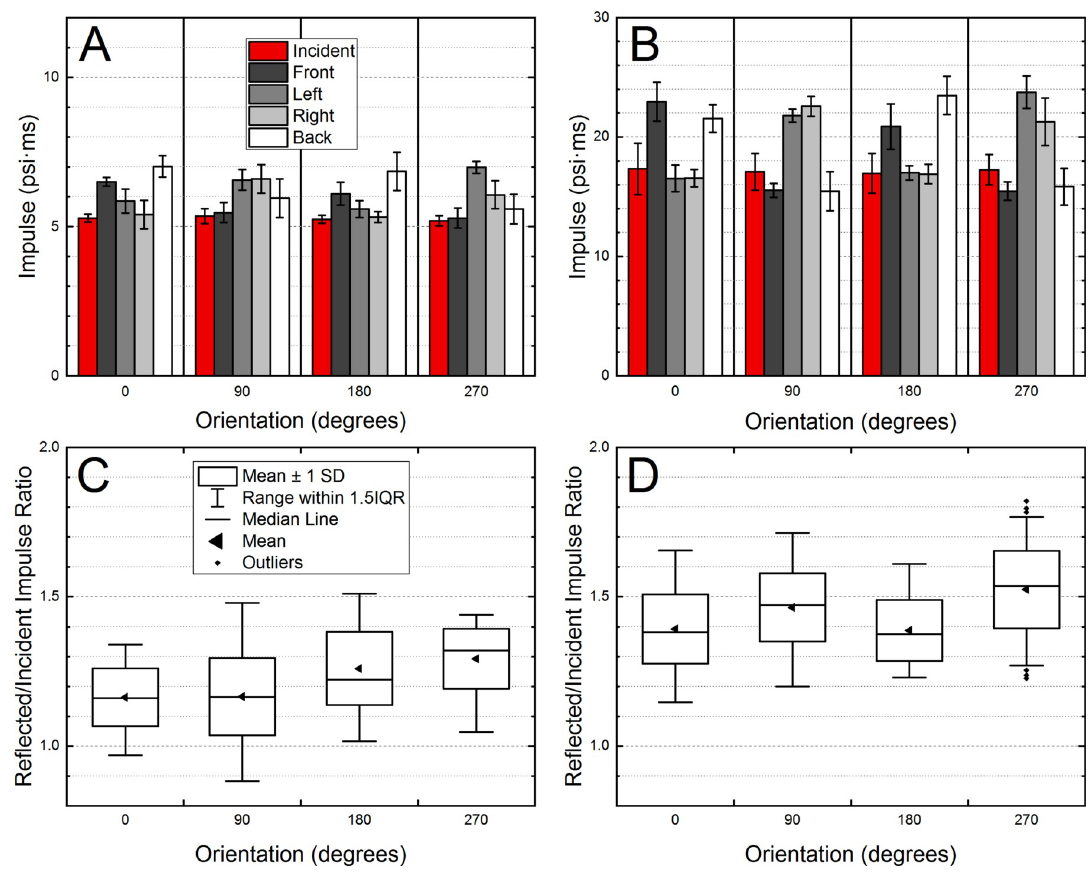
Fig 4. The results of the quantification of the overpressure waveforms recorded by the B3 Blast Gauge on the ACH helmet. Four sensors were used, and the helmet was rotated in 90 degrees intervals. The impulse at 5 psi (A) and 10 psi (B), and corresponding reflected-to-incident ratios (C, D) were